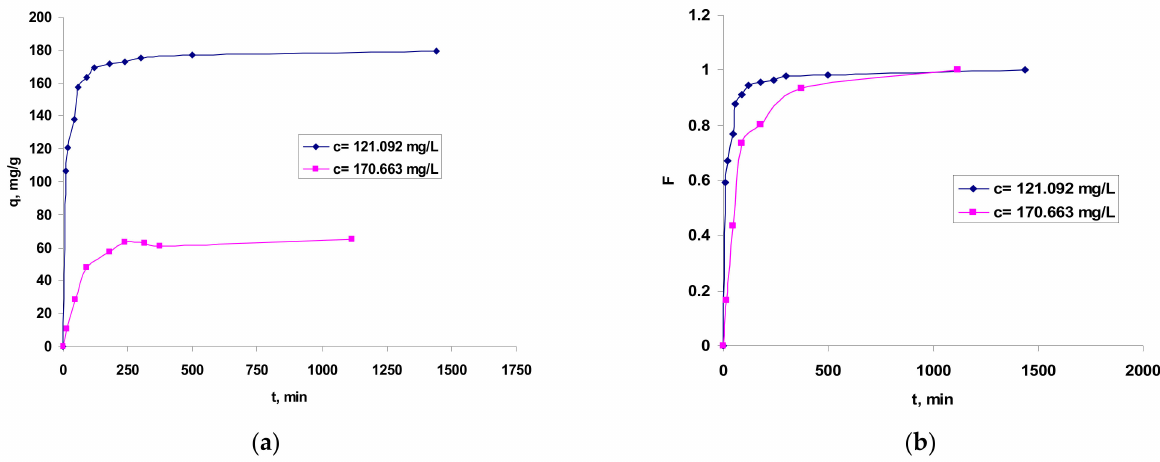
Figure 6. Influence of contact time in Co 2+ ions biosorption onto OxC25 hydrogel vs. (bio)adsorption capacity ( a ) and fractional equilibrium attainment ( b ). Operational conditions: adsorbent concentration of 0.4 g/L; pH = 1.5; temperature of 20 ◦